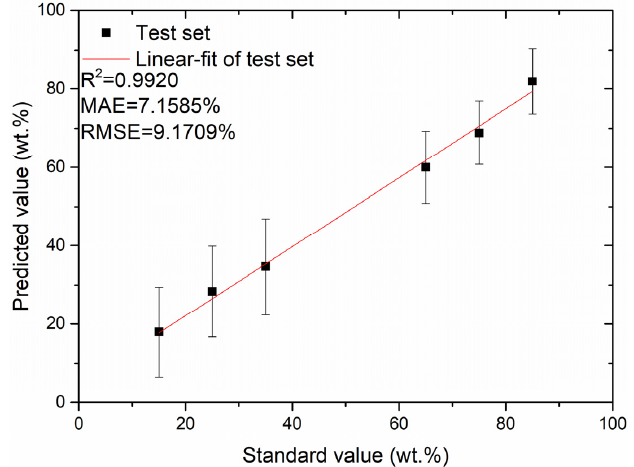
Figure 4. Effect of the number of PCs on the performance of the PLSR quantitative analysis model. From Figure 4, the RMSEP of the training set fluctuates with the increase in PC num- ber, exhibiting a general decreasing trend. When the number of PC is 64, the lowest RMSEP value is obtained via the PLSR quantitative analysis model. Therefore, the first 64 PCs are chosen for the test set data analysis. The relationship between the predicted and